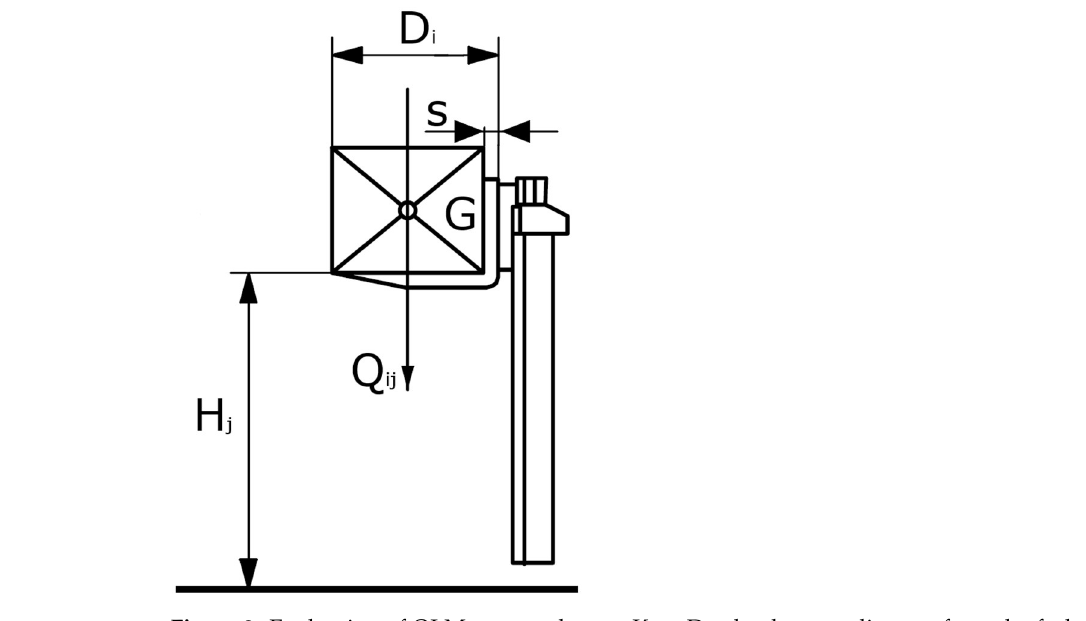
Figure 2. Evaluation of OLM: nomenclature. Key: D i —load centre distance from the fork carrier; H j — lift height; Q ij — rated capacity according to D i and H j ; s — fork arm blade thickness.